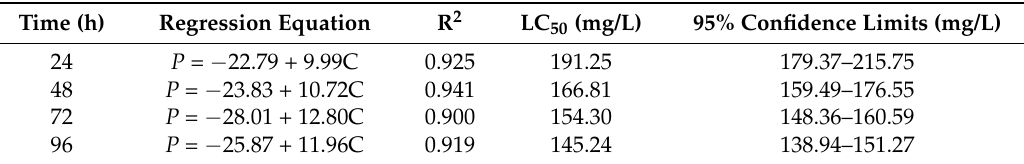
Table 1. Regression equations, Lethal Concentration 50 (LC 50 ) values, and 95% confidence limits of